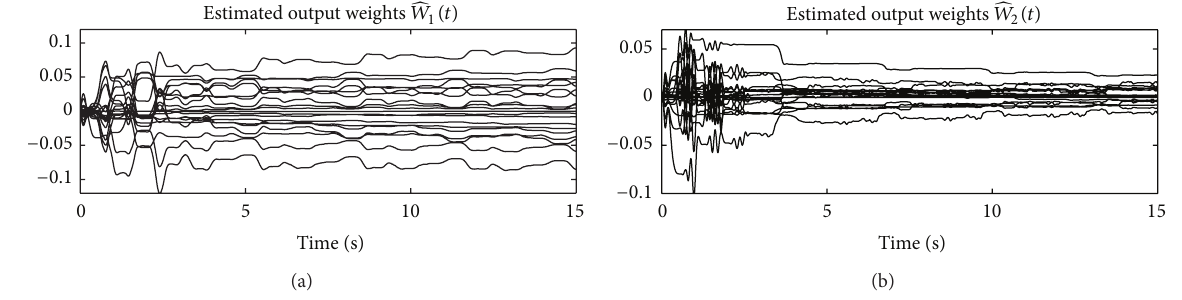
̂𝑊 (𝑡) ∈ R 10×1 and ̂𝑊 1